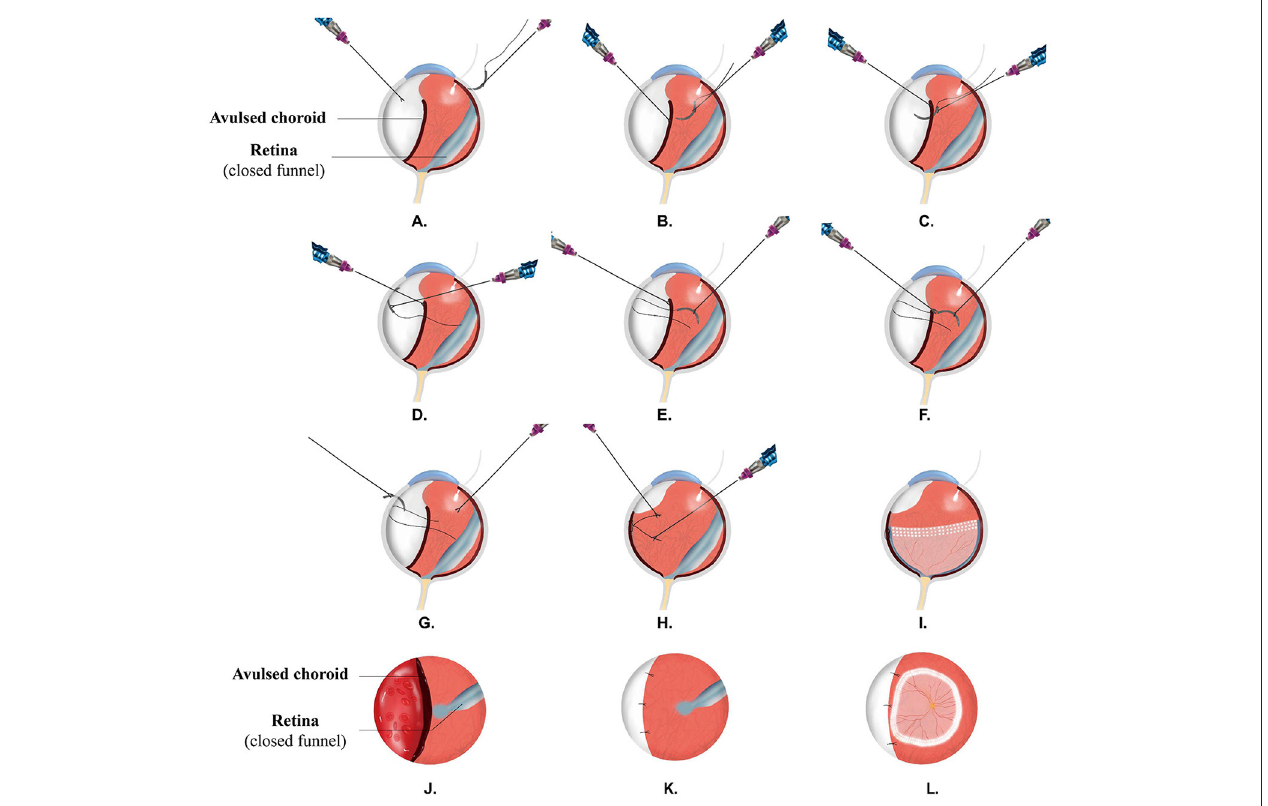
FIGURE 2 | Surgical procedures of IOS. IOS: intraocular suturing. (A-I) presents the sideview. Chandelier illumination was used to assist bimanual manipulation, (A) a needle with 8-0 polyglactin suture was introduced into the vitreous cavity through the right port of 20-G sclerotomy, (B) two intraocular forceps were inserted, with the right forceps holding the needle and the left one capturing the anterior margin of the avulsed choroid to accomplish the suturing. The needle passed through the full-thickness choroid (C) , lamellar sclera (D) , and through the choroid again (E) ; suture at the needle side was cut (F) , and a needle was taken out of the eye (G) before a knot was tied (H) by the two intraocular forceps, (I) a retinal funnel was unfolded, and retina was reattached. (J-L) presents the front view. (J) Showing avulsed choroid with closed funnel retinal detachment, (K) the avulsed choroid was refixed to the sclera with intraocular-interrupted suturing, and the connection of vitreous cavity and suprachoroidal cavity was blocked, (L) the retinal funnel was unfolded, and retina was reattached.